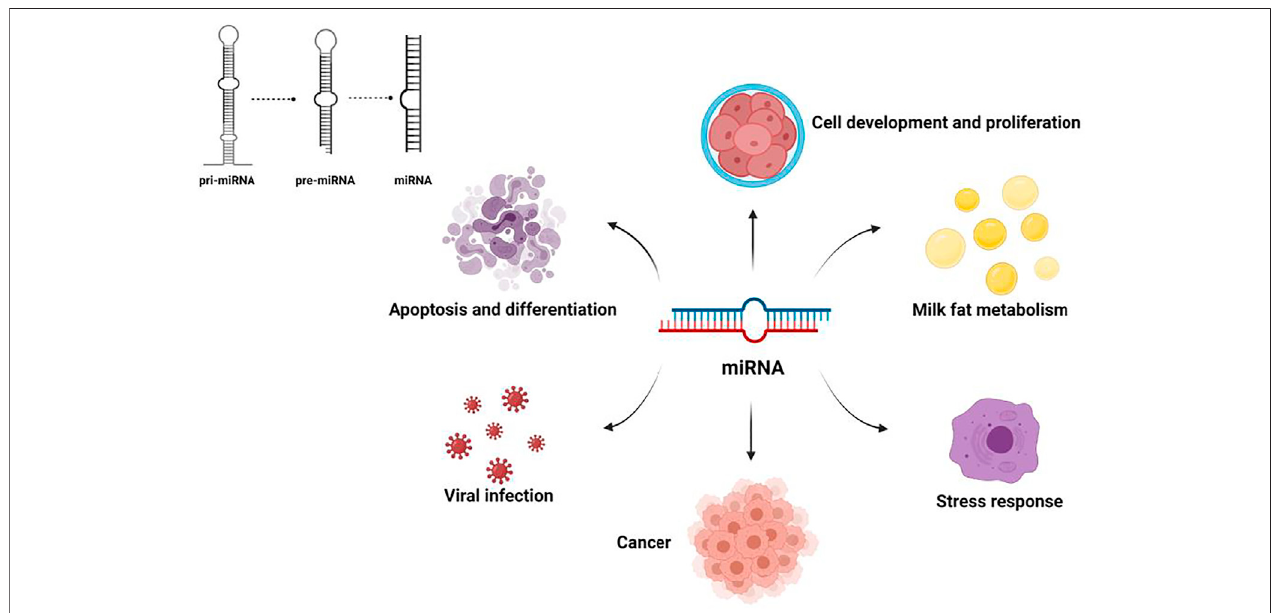
FIGURE 1 | Major functions of